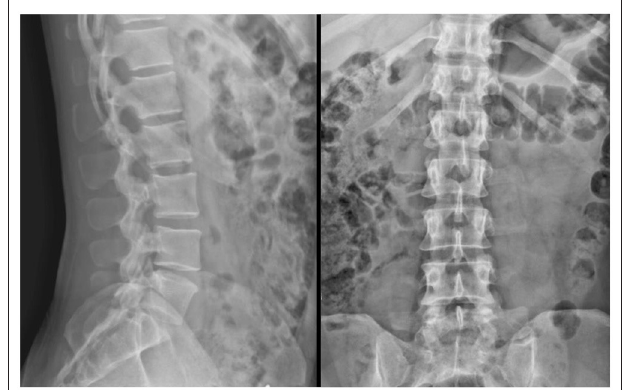
FIGURE 1 | Lateral and AP, Lateral Xray othe lumbar spine—impression: no spondylolisthesis is evident, no fracture, normal bone density, and no lytic or blastic lesions are present.